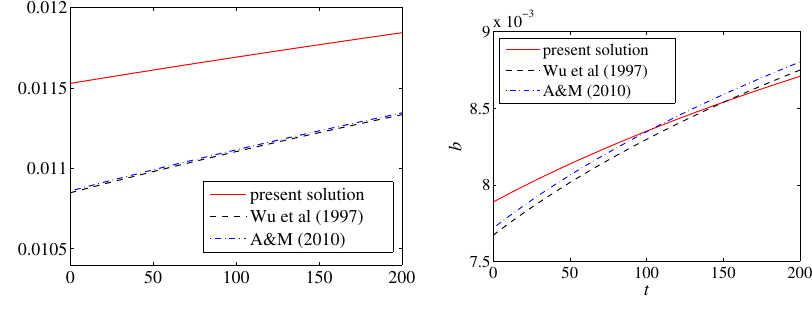
Figure 4. Comparison of the values of the parameter b in different models; left - for h = 1, right - for h = 0 . 5.